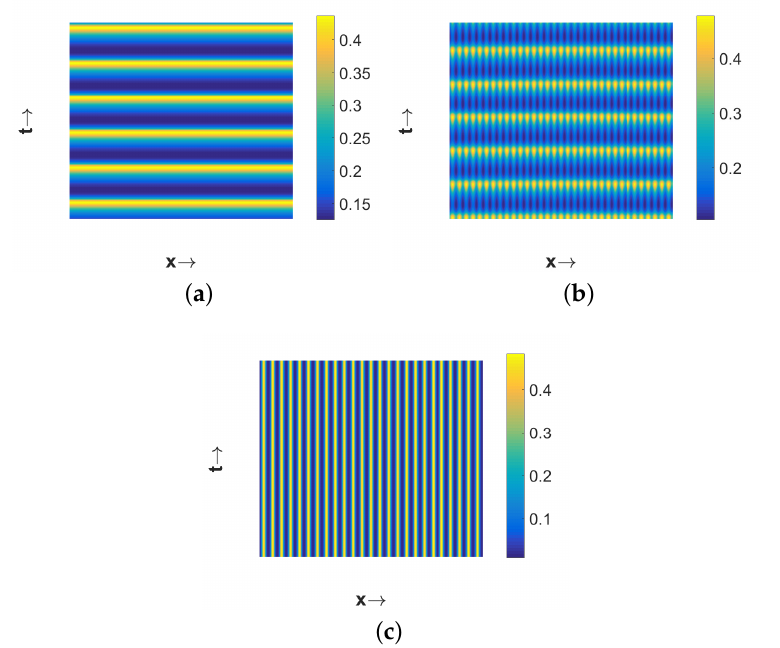
Figure 5. Plots of different types of patterns exhibited by u 1 for (cid:101) = 6.0. Three different patterns are obtained for ( a ) d 3 = 3.0; ( b ) d 3 = 3.75; ( c ) d 3 = 9.0. Other parameter values are mentioned in